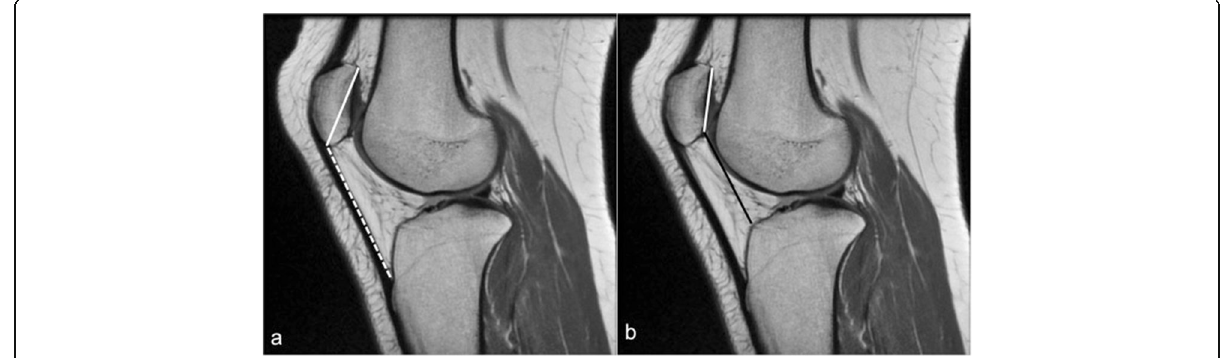
Fig. 4 Patella alta assessment. a Sagittal PD knee MRI showing the method of assessing the Insall – Salvati index, calculated as the ratio of the patellar tendon length at its inner aspect (white dashed line) to the greatest diagonal length of the patella (white line). b Patellar alta evaluation using the Caton – Deschamps index, which is the ratio between a line measured between the inferior margin of the patellar articular surface and the anterior aspect of the tibial plateau (black line) and the greatest length of the patellar articular surface (white line)